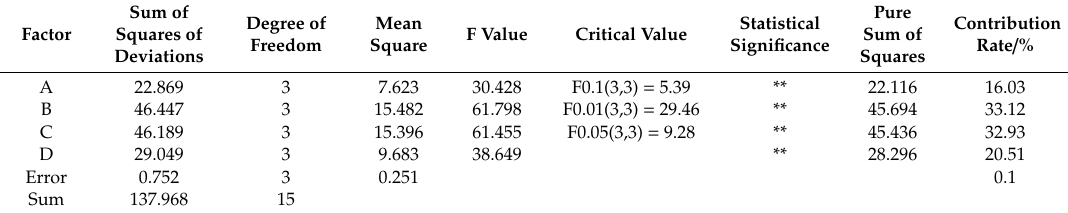
Table 8. Variance Analysis and Contribution Rate of Factors and Errors to Compressive Strength.